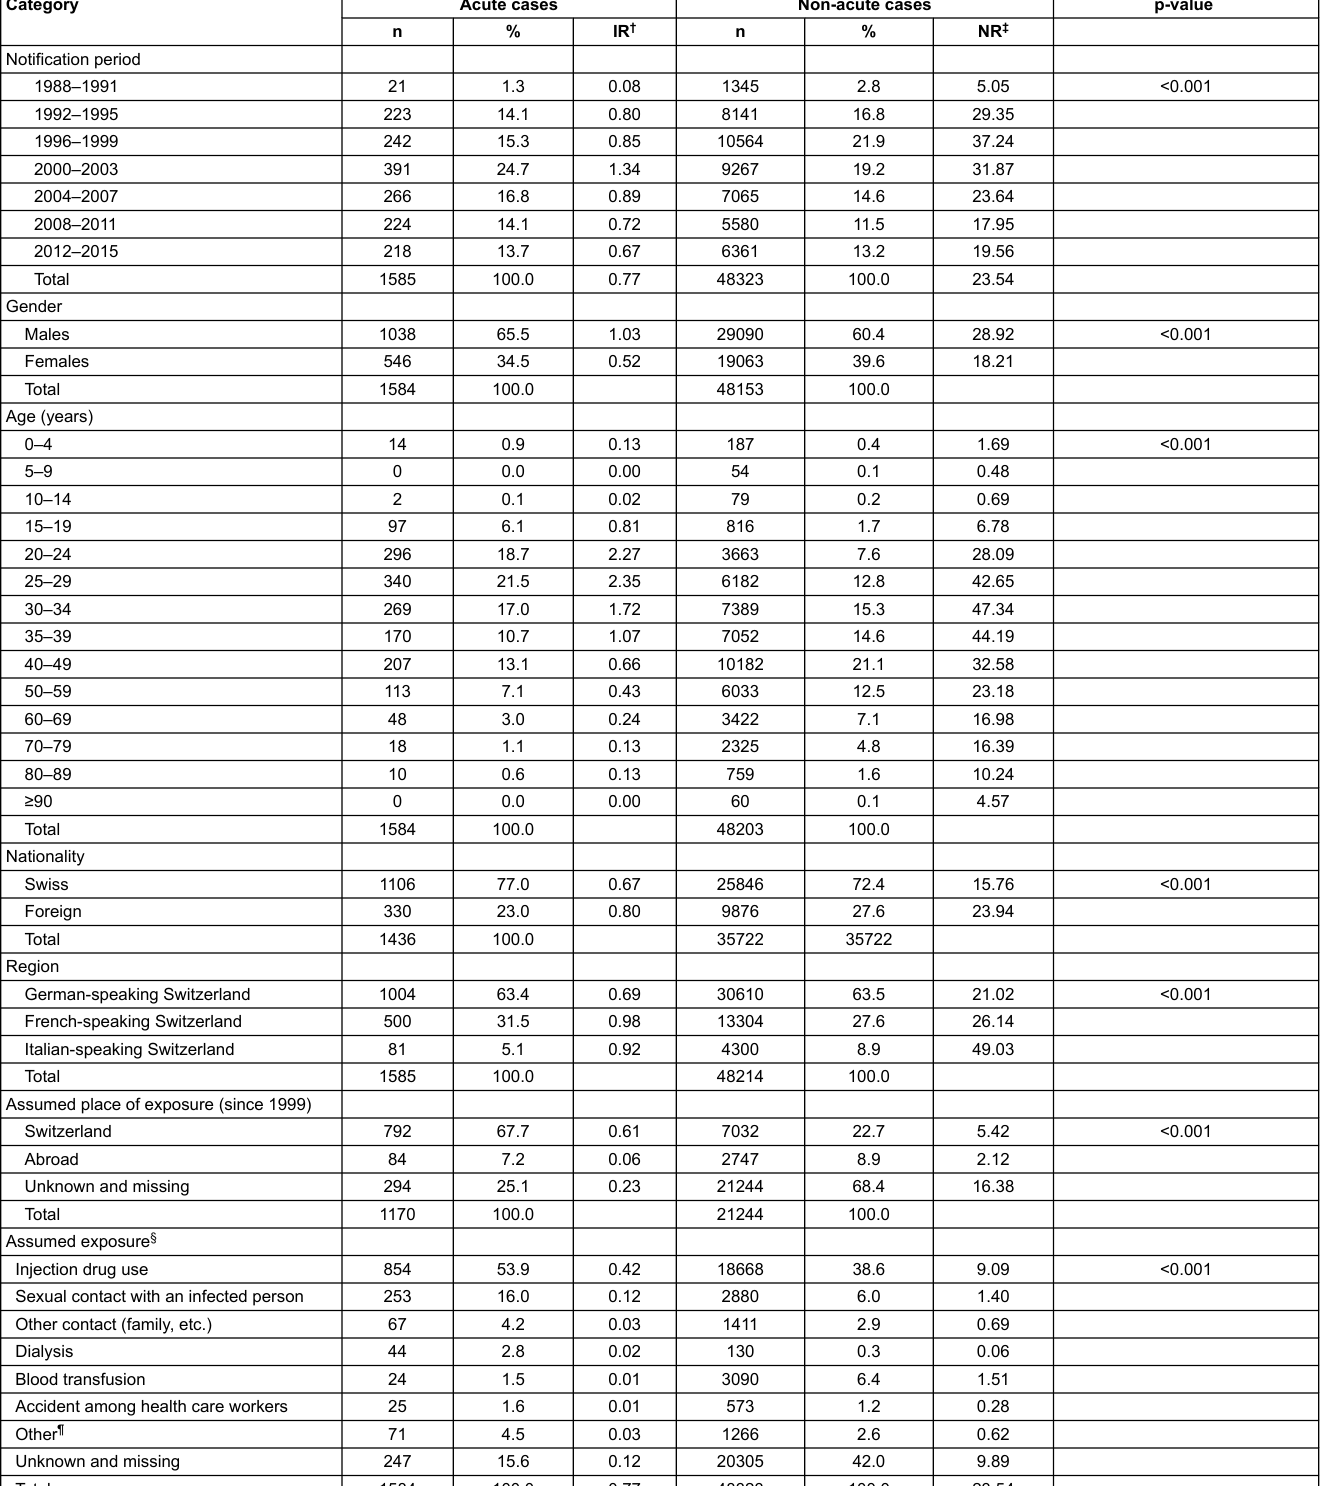
Table 1: Comparison of characteristic features of notified acute and non-acute HCV cases, Switzerland,